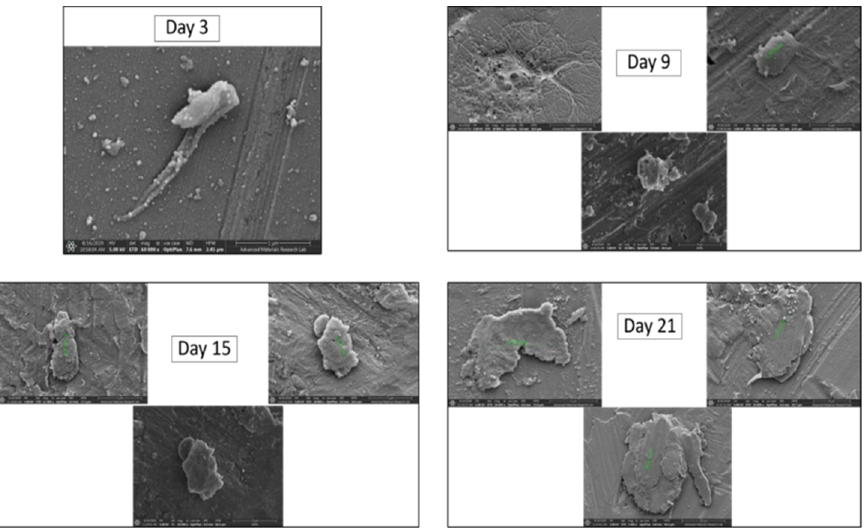
Figure 2. SEM images showing the morphological changes in iMSCs as it progresses towards differentiated PDGFR α -positive cells. The samples were fixed and dehydrated on day 3, 9, 15, and 21 of the experiment.